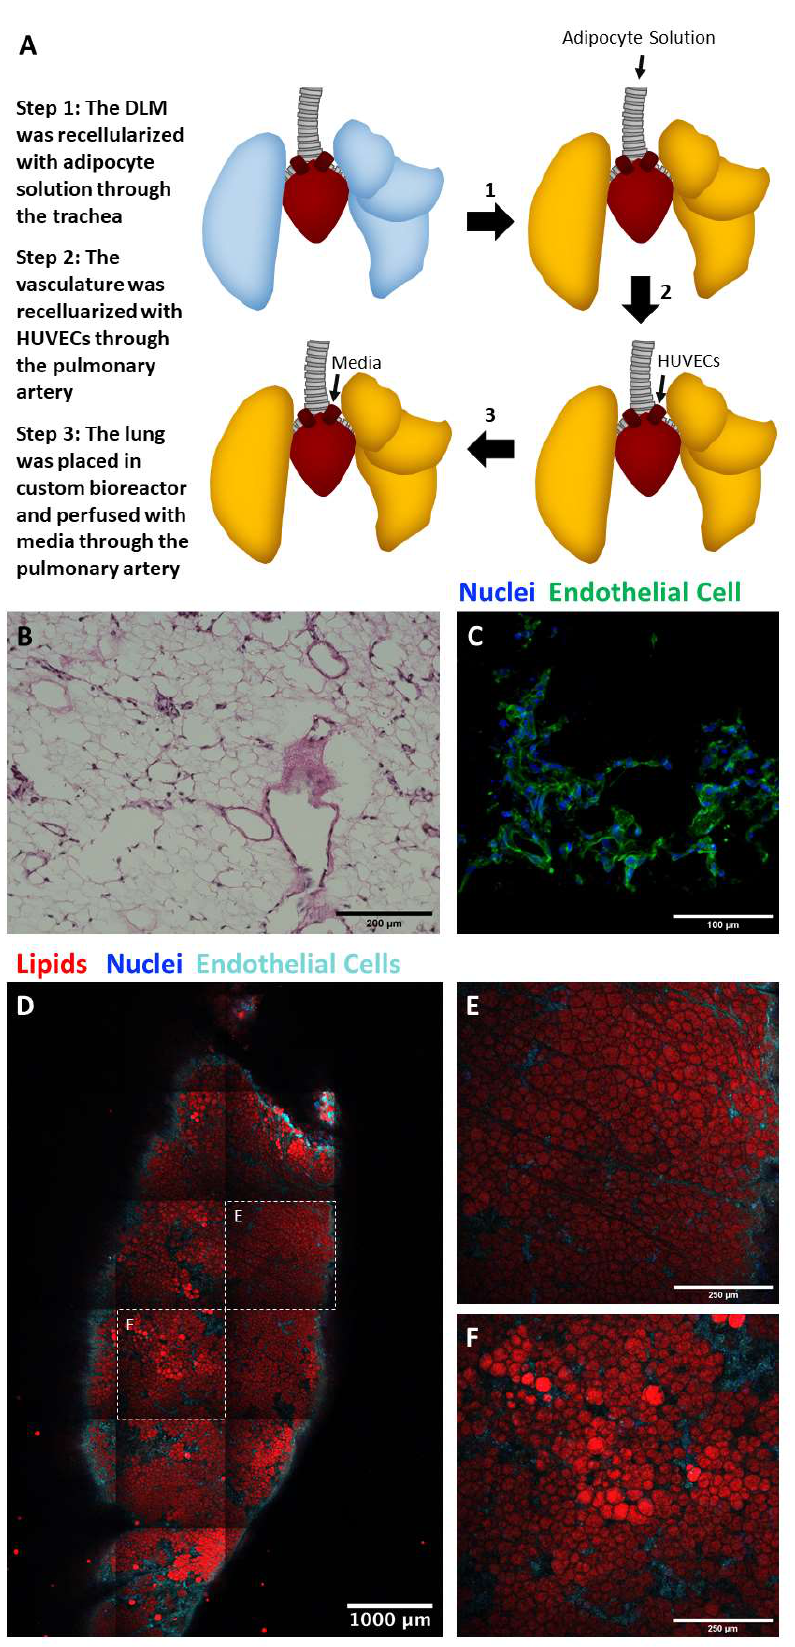
Figure 6. Effective delivery of adipocytes and endothelial cells into the alveolar and vascular compartments of the DLM. ( A ) Schematic showing how adipocytes and endothelial cells were